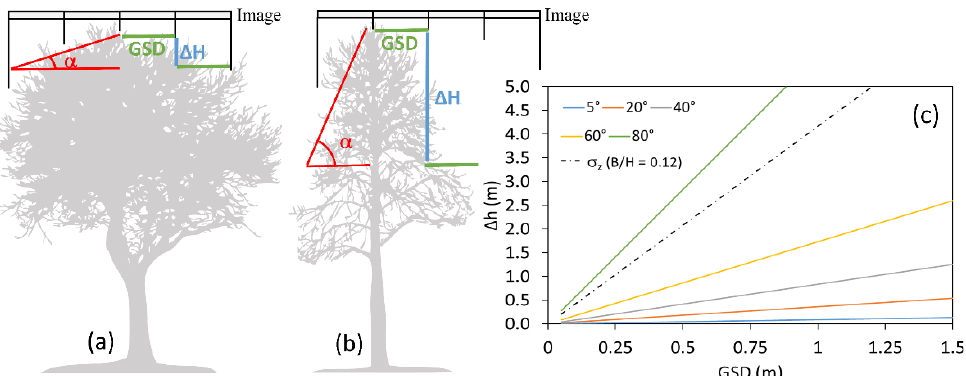
Figure 2. ( a ) Broadleaf tree; ( b ) conifer tree; ( c ) ∆h is the height difference in crown geometry corresponding to the GSD size of DSM/CHM (GSDd). It depends on the α value. Broadleaves show values reasonably ranging between 5° and 45°, while for conifers this is greater than 45°.